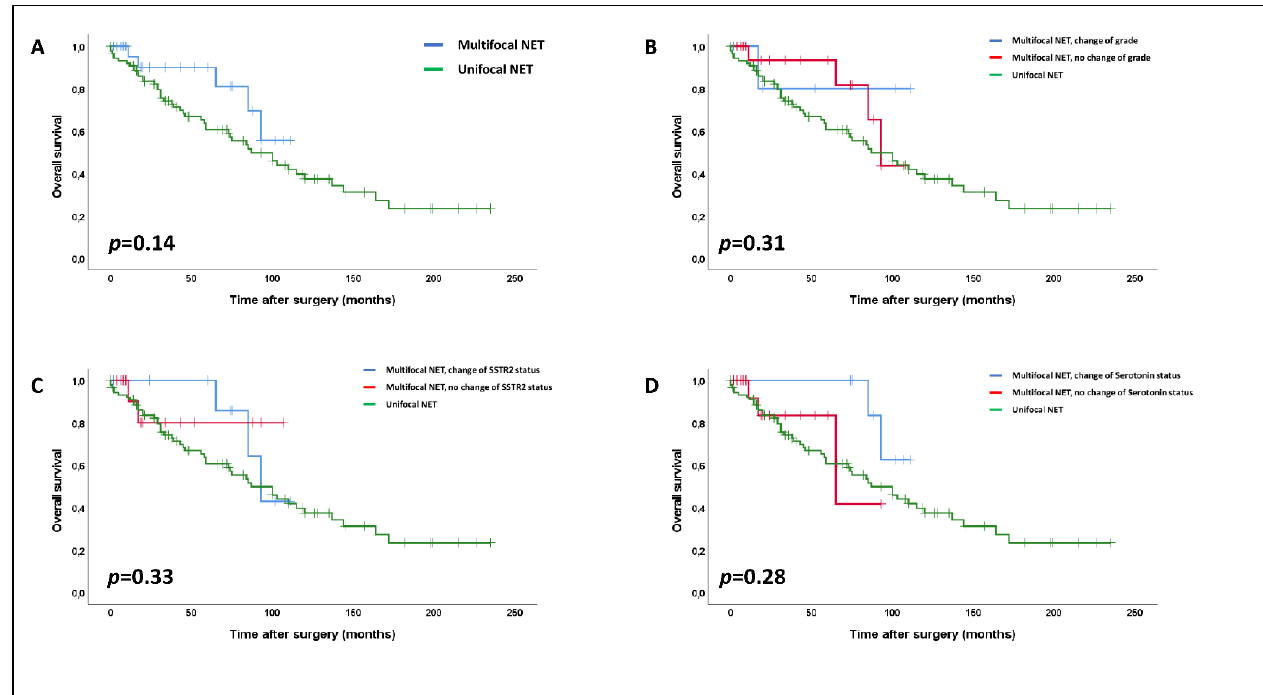
Figure 4. Impact of multifocality ( A ) and of intertumoral heterogeneity regarding the WHO-grade ( B ), SSTR2 status ( C ) and serotonin expression ( D ) on overall survival within multifocal SI-NETs compared to unifocal SI-NETs (log-rank rest). The vertical bars in the Kaplan – Meier curves show censored patients at the respective time points.